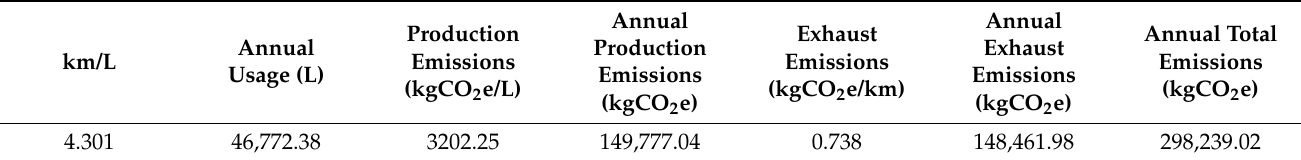
Table 7. Diesel ICE Powertrain Usage Calculations.